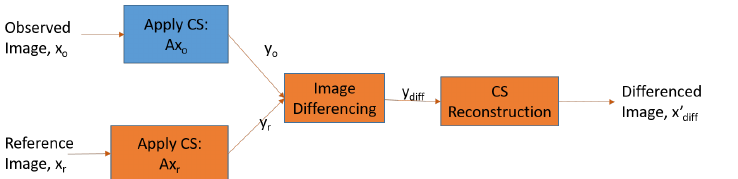
Figure 1. CS Architecture. The blue block represents CS data acquisition which can be performed on-board a spaceflight instrument, while the orange blocks represent computations which can be performed on the ground. Image differencing can also be performed on-board to further reduce data volume.